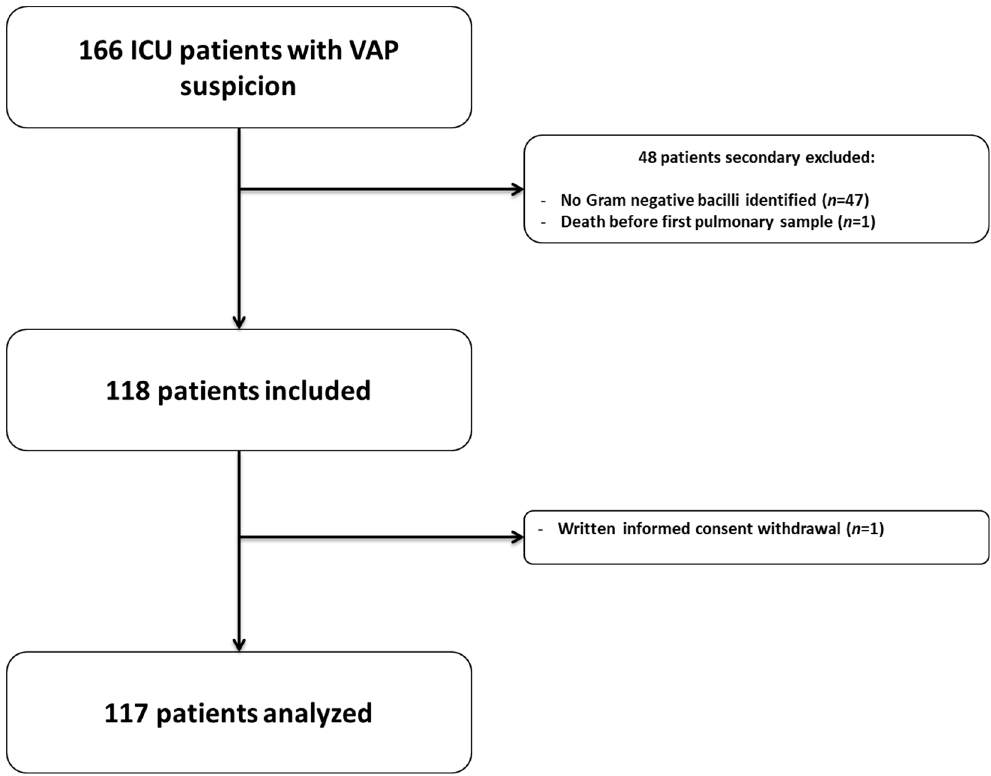
Figure 1. Flowchart. Table 1. Demographics and clinical characteristics of the 117 patients at baseline and day 1.